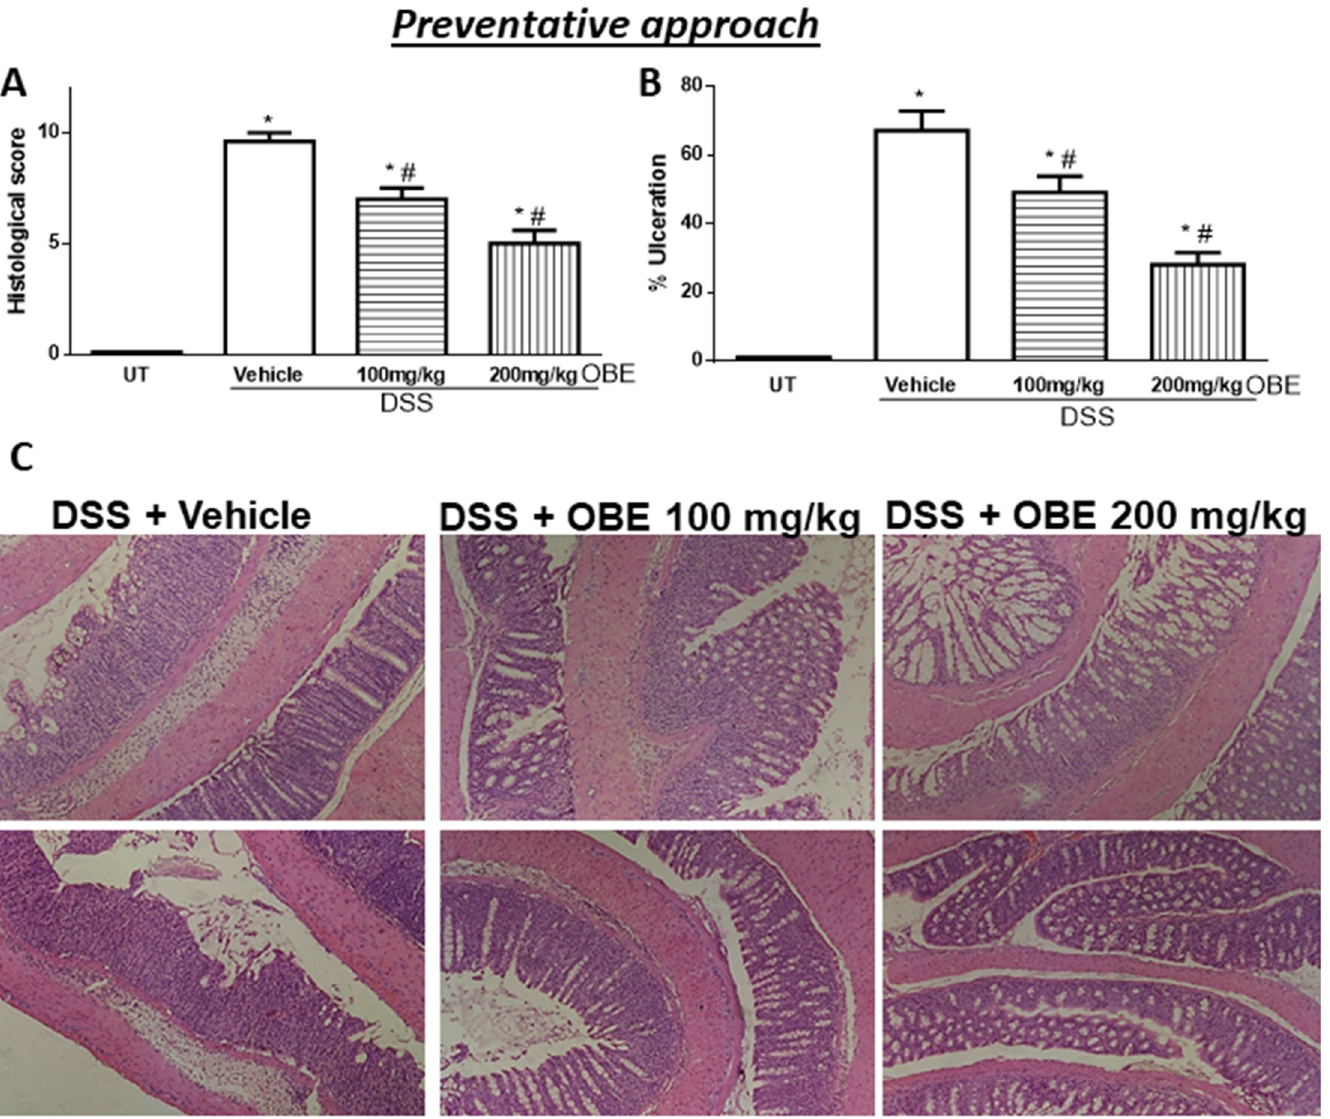
Fig 6. Effect of OBE on colitis severity at the histological level using the preventative approach. The histological assessment of colitis severity (panel A), and the % of ulceration in the whole colon section (panel B) were determined in mice receiving DSS and either vehicle (solid bars), or various doses of OBE (hatched bars) and in the UT healthy mice (open bars). Histobars represent means ± SEM for the following number of mice in each group: UT (n = 7), DSS/vehicle (PBS) (n = 12), DSS/OBE 100 mg/kg (n = 13), and DSS/OBE 200 mg/kg (n = 7). Asterisks denote significant difference from UT mice with p < 0.05 ( � ), # denotes significant difference from DSS/ vehicle-treated mice with p < 0.05. Panel C (left side) is an illustration of a colon section taken from mouse treated with DSS/vehicle where there is significant mucosal destruction, submucosal edema formation, increase muscle thickness, and significant immune cells recruitment. The middle and left sides are illustrations of typical colon sections taken from mice treated with 100–200 mg/kg doses of OBE. There was an improvement in the mucosal integrity and reduced the enhanced immune cells recruitment (10x magnification).